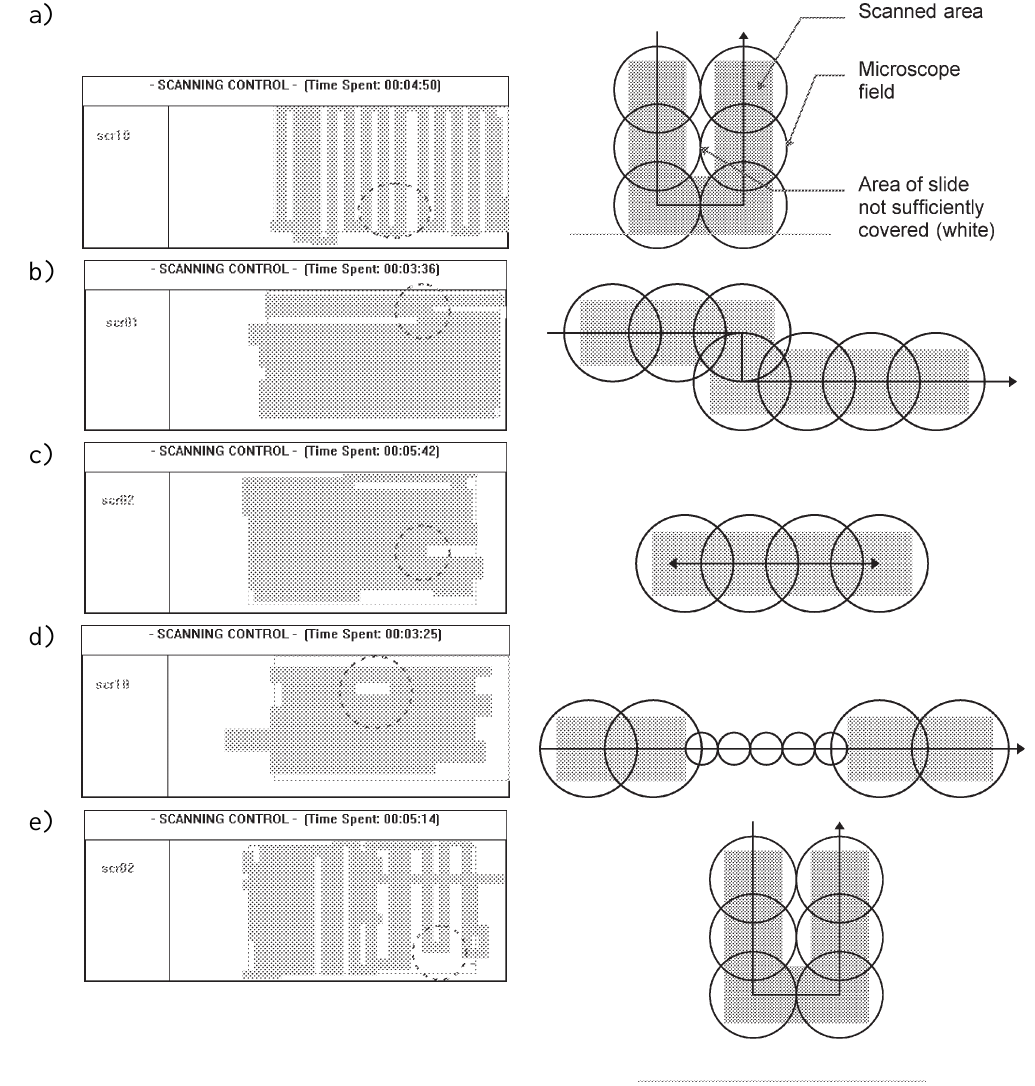
Fig. 5. (a) Insufficient overlap of fields (referred to herein as “underlap”). (b) Failure to retrack scanning track after HP observation at periphery of field (referred to herein as “retrack”). (c) Reversal of screening direction after HP observation (referred to herein as “reversals”). (d) Screening on high power objective (referred to herein as “HP screening”). (e) Screening direction change before edge of coverslip is reached (referred to herein as “early turn”) nb. “underlap” also shown